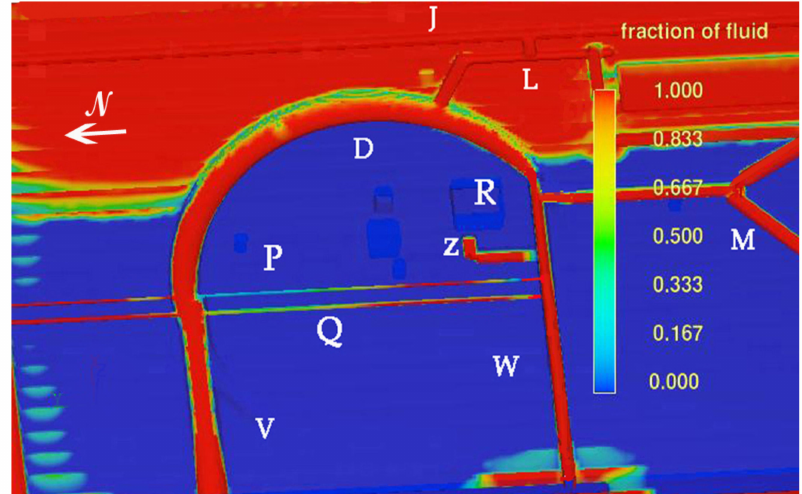
Figure 8. Case 1 fluid fraction results at P-Q depth from the ground surface; water input from channel M to subterranean channels P and Q flush wastewater from the Putuni Palace complex to drainage canal arm V then on to the Tiwanaku River A’-B’ and Lake Titicaca. Z indicates a water channel connection from the Kalasasaya Platform to the perimeter drainage